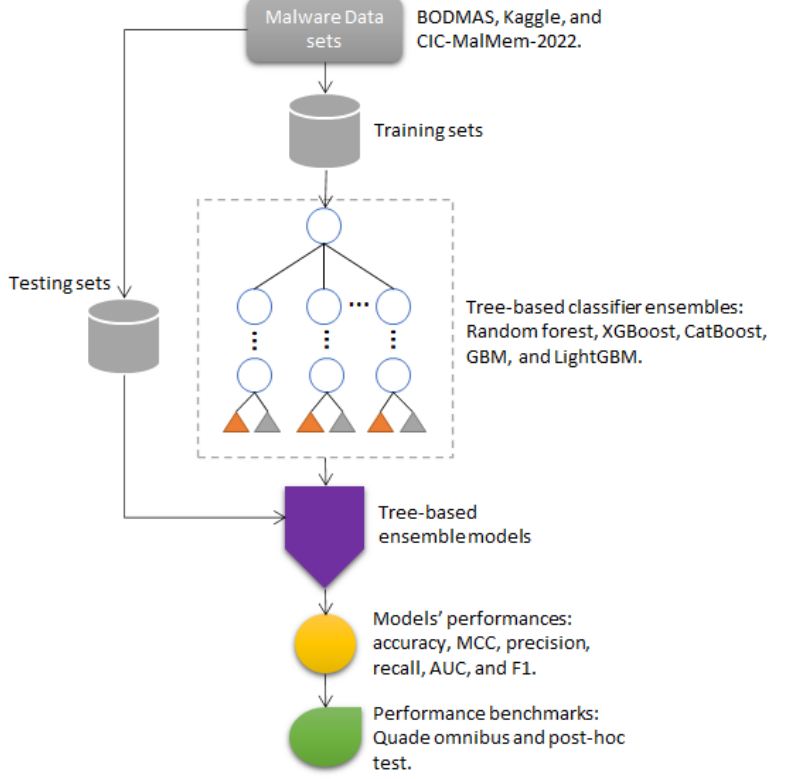
Figure 1. Performance comparison methodology of tree-based ensembles for PE malware